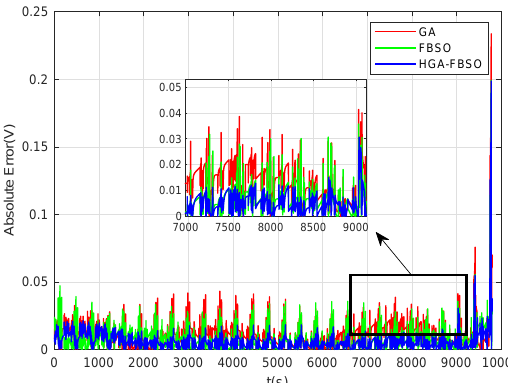
Figure 4. Output terminals voltage AE with the GA, FBSO and HGA-FBSO.